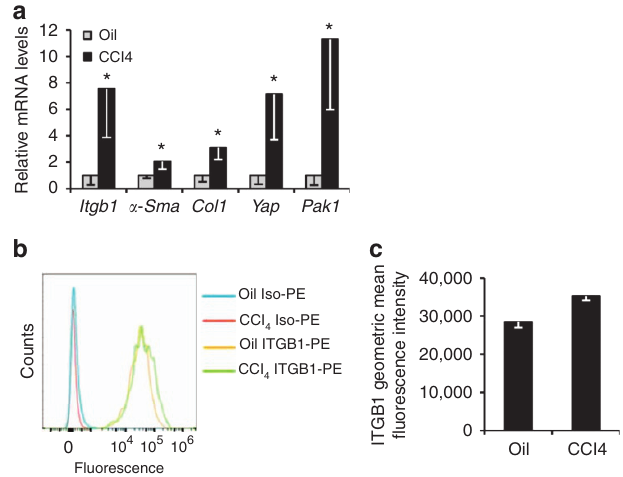
for therapeutic repositioning 41,42 . In summary, these data report new mechanisms for liver fibrosis involving the group 1 PAK proteins and YAP-1 as important effectors of integrin-dependent signalling in hepatic myofibroblasts and highlight PAK inhibitors as potential new agents with which to target liver fibrosis in patients.